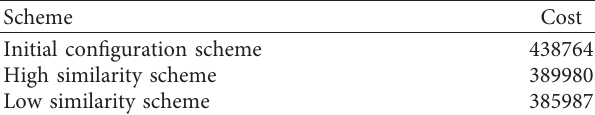
Table 6: Cost of different schemes.